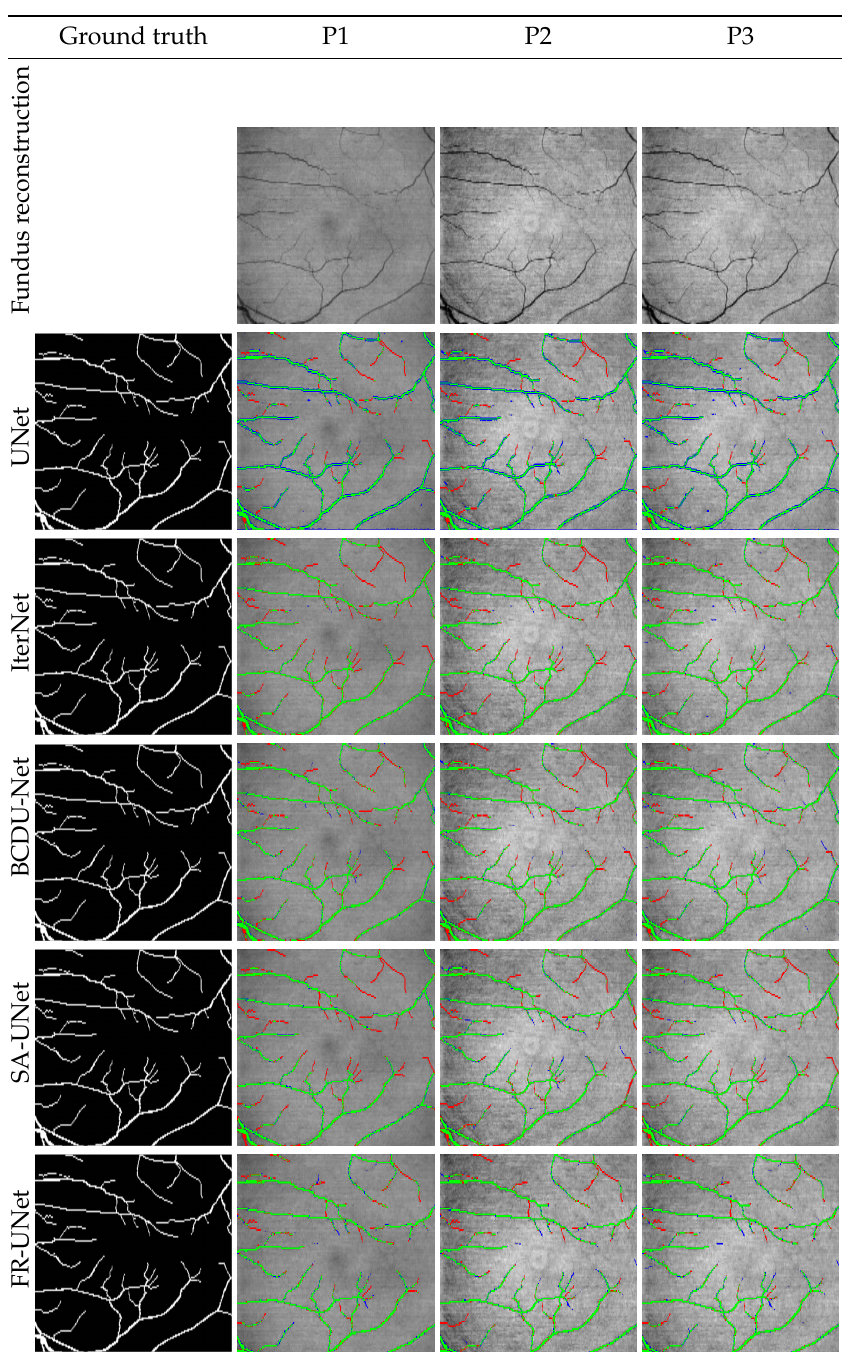
Figure 15. Example fundus reconstructions with ground truth and corresponding segmentation results for all neural